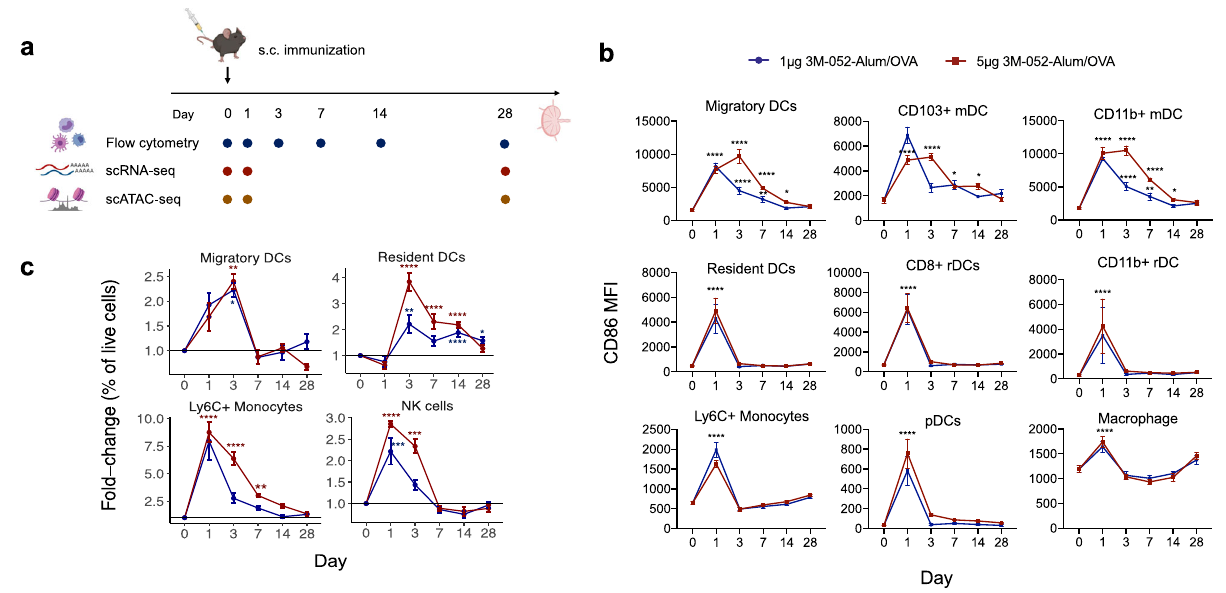
Fig. 1 3M-052-Alum/OVA induces changes in activation and cell frequency of innate immune cells in the draining LN on Day 1. a Schematic of fl ow cytometry phenotyping, CITE-seq and scATAC-seq in this study. b Mean ± SEM of CD86 median fl uorescence intensity (MFI) in innate immune cell subsets from the dLNs at each timepoint ( n = 5 for each group; naïve group pooled from three independent experiments, n = 15). Two-way ANOVA with Dunnett ’ s multiple comparisons test in comparison to Day 0 (*, adjusted p -value < 0.05; **, padj < 0.01; ****, padj < 0.0001). c Fold-change of mean % live cells ± SEM across innate immune cell subsets in the dLNs at day 1 post-immunization compared to naïve control ( n = 5 for each group; naïve group pooled from three independent experiments, n = 15). Two-way ANOVA with Dunnett ’ s multiple comparisons test in comparison to Day 0 (*, adjusted p -value < 0.05; **, padj < 0.01; ****, padj < 0.0001). Source data are provided as a Source Data fi